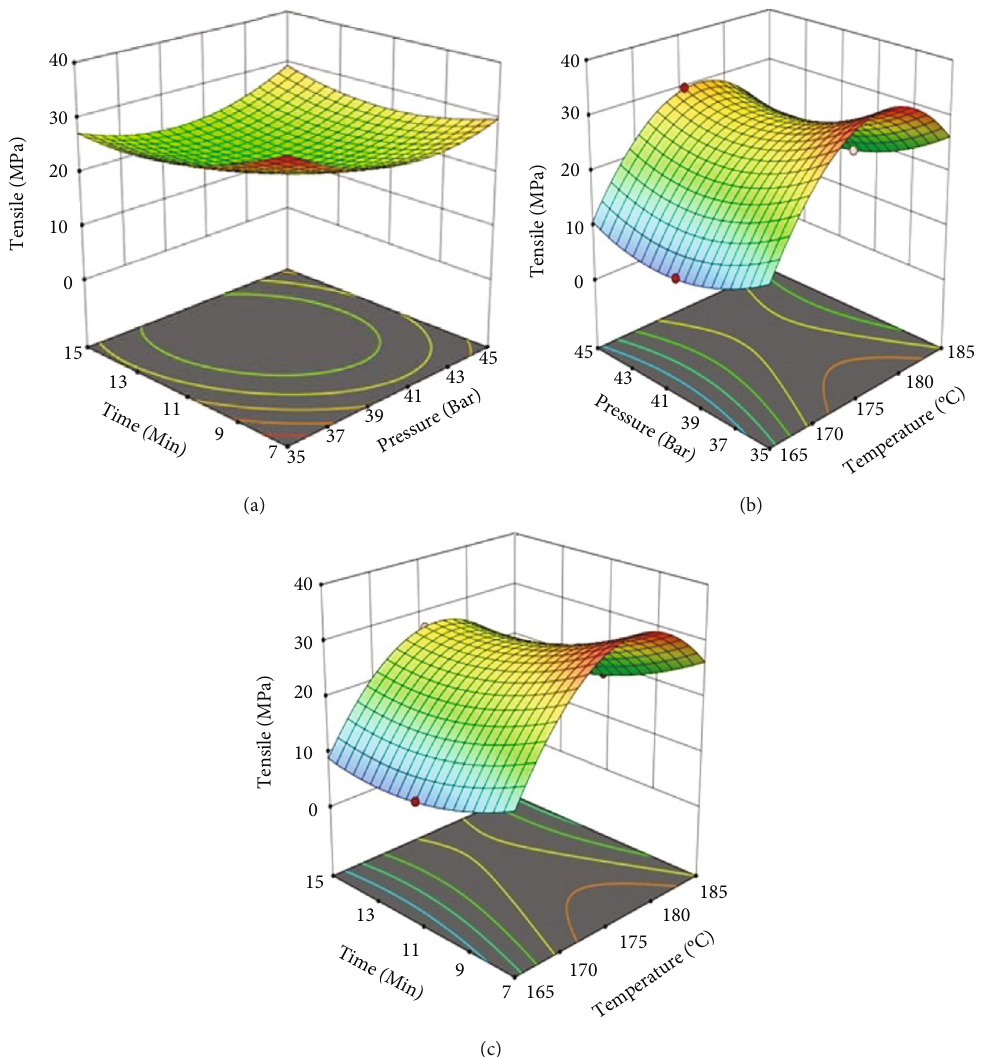
Figure 5: Tensile behavior of (a) pressure vs. time; (b) temperature vs. pressure; (c) temperature vs. time of CGF- and hemp-based hybrid